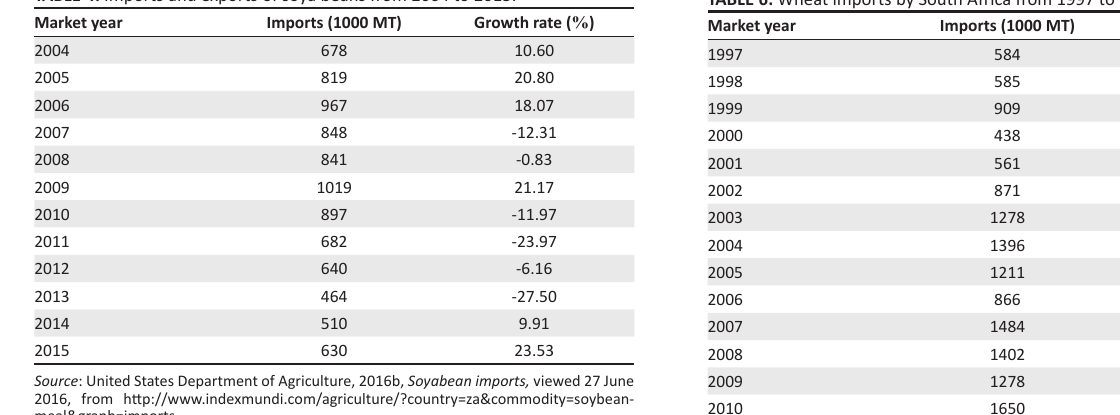
TABLE 5: Capacity of existing grain silos in South Africa. Silo owner Storage capacity Cooperatives (north)